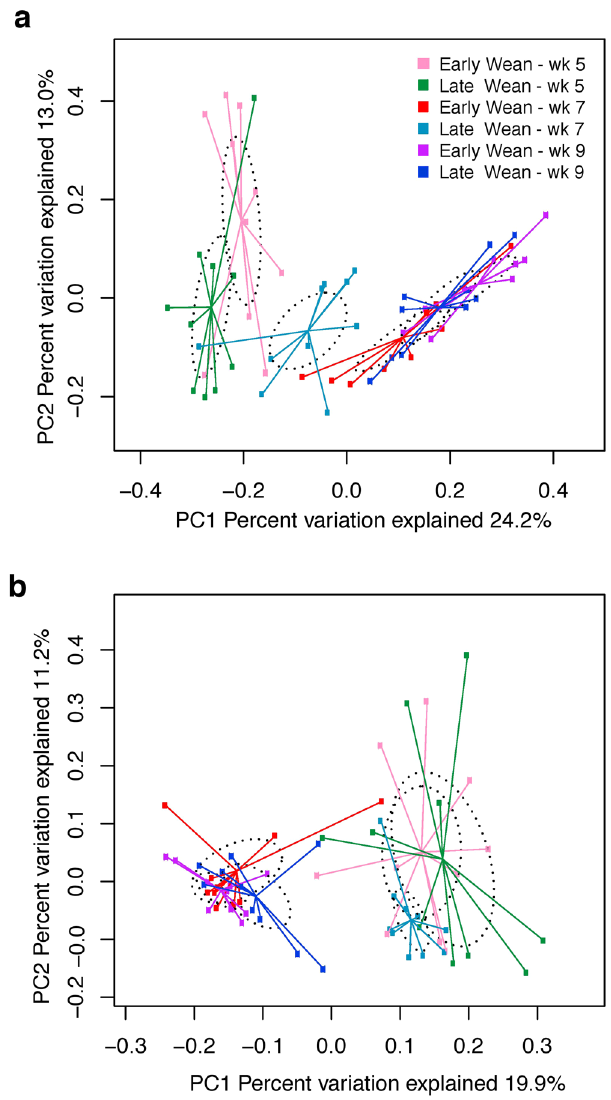
Figure 1. Similarities of ruminal and faecal microbiota compared across weaning age [early-weaned (Wk 6) vs. late-weaned (Wk 8)] and calf age (Wk 5, Wk 7 and Wk 9). Distance between the samples, based on similarity in OTU composition (OTU similarity ≥ 97%) calculated using weighted UniFrac distance in the a) rumen, and b) faeces, were visualised in principal coordinates analysis (PCoA) plots. A greater distance between two points infers a lower similarity. The impact of weaning age × calf age on the clustering pattern of microbial communities was tested using PERMANOVA (implemented in PRIMER-6 software; significance was declared when P < 0.05). Within the rumen, weaning age × calf age differed (P = 0.035) across all ages and groups, with the exception (P > 0.05) of early- versus late-weaned calves at 9 weeks of age, which were similar. Weaning age × calf age also differed (P = 0.004) in the faeces, with the exception (P > 0.05) of early- versus late-weaned calves at 5 and 9 weeks of age, and in early-weaned calves aged 7, compared to 9 weeks of